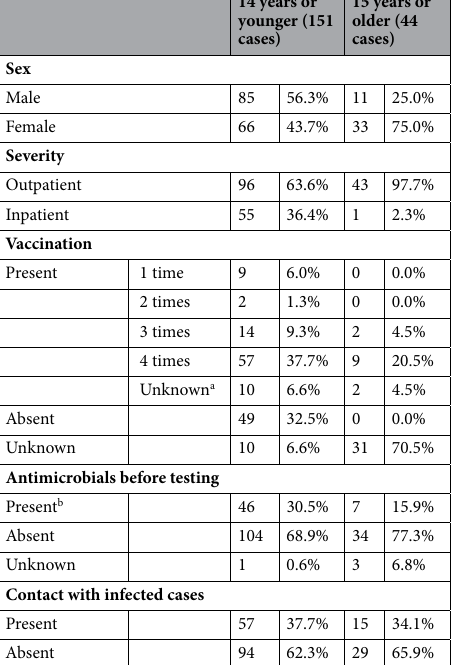
Table 2. Baseline demographics. A total of 195 cases were analyzed. Of them, 151 cases were 14 years or younger, and 44 cases were 15 years or older. a Vaccination is present, but the number of vaccinations is unknown. b Macrolides were administered in 21 cases, cephem antibiotics in 18 patients, penicillin in 7 patients, and other antimicrobials in 7